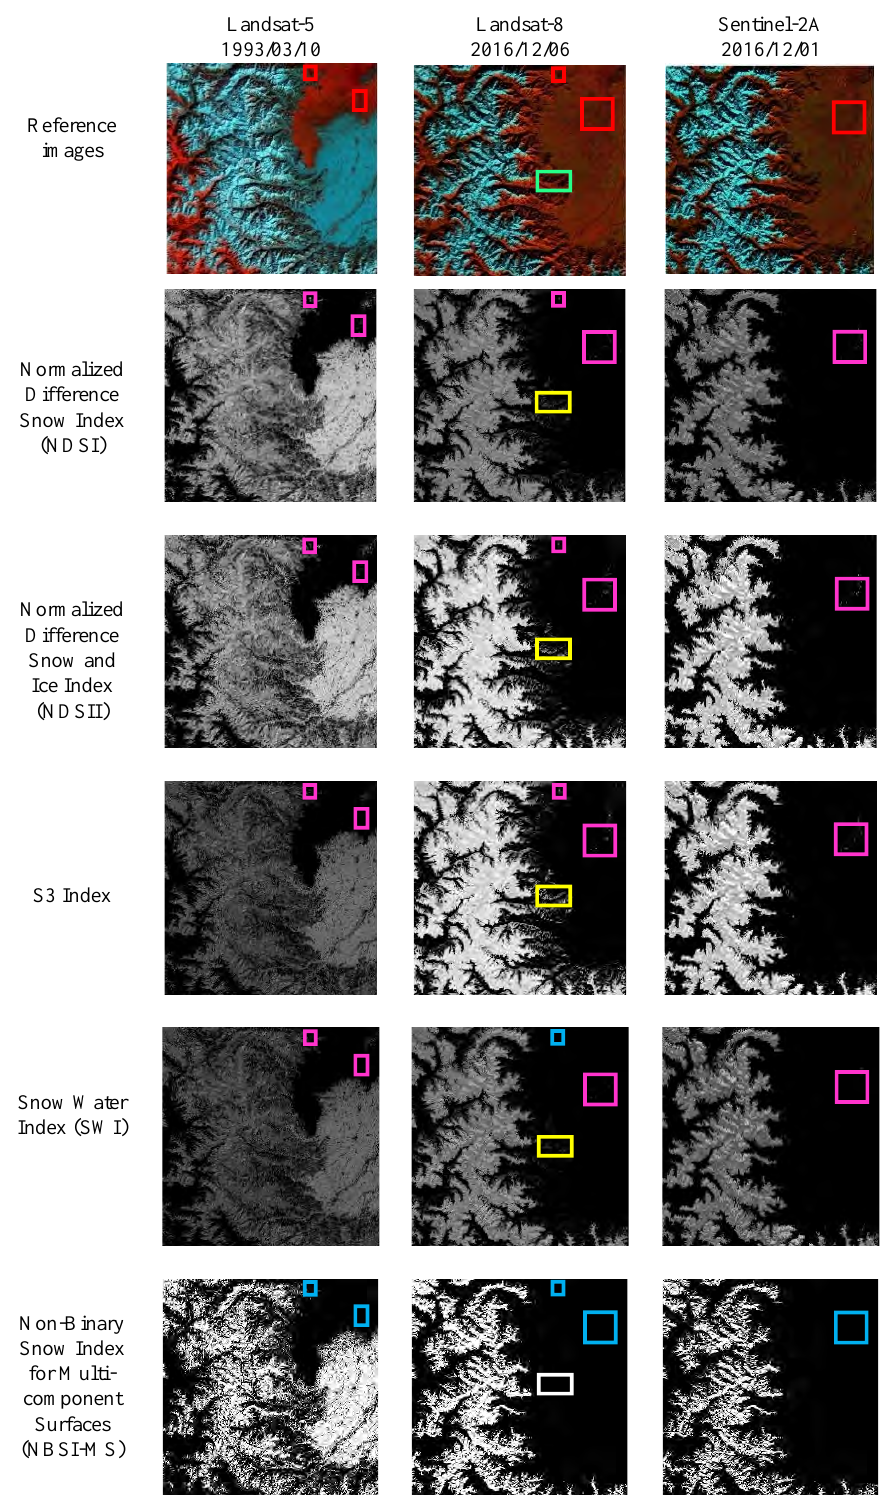
Figure 10. Snow cover extraction maps produced by the Snow-Cover Indices without binarization in the France–Italy region recorded by the Landsat and Sentinel-2A satellites on different dates. The green rectangle in the resultant index maps of Landsat 8 highlights that NDSI, NDSII, S3, and SWI did not remove Hilly Shadow over Vegetation (yellow rectangles) as opposed to NBSI-MS (white rectangle). The reference color images are used to enhance the amount of snow cover in blue